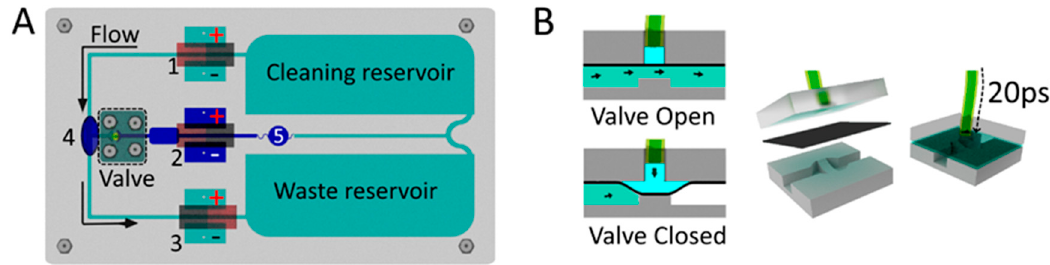
Figure 2. MHD chip with a multi-pump network: ( A ) Superior view: 1, 2, and 3 are the MHD pumps; 4 is the detection cell and detection point (RGB); and 5 is the analyte / electrolyte mixing barrier. ( B ) Lateral view of the valve: the valve is normally open, but when pressure (20 psi) is applied on the liquid connected to the polydimethylsiloxane (PDMS) membrane layer, the valve closes.